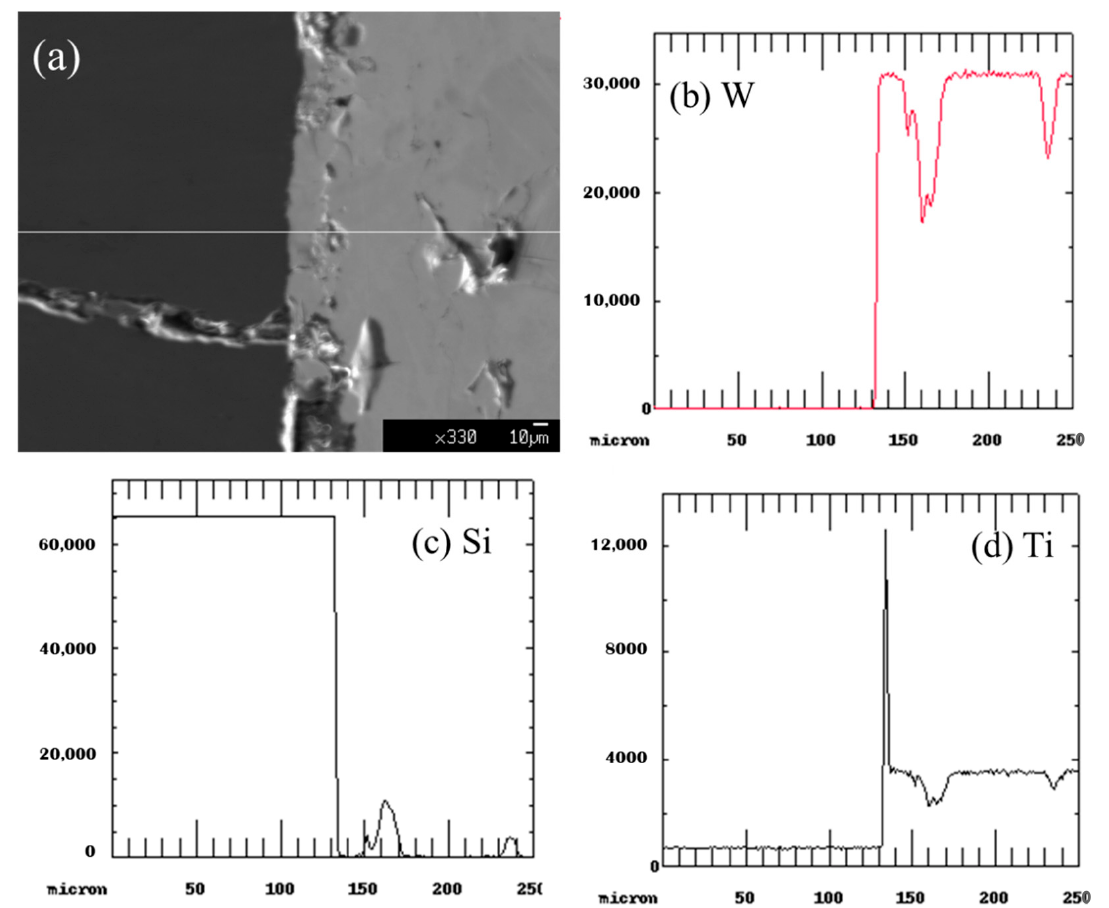
Figure 13. SEM images and EPMA results of cross-section of sputtered coated SiC joined with Wfoils. ( a ) cross-sectional SEM images of TiN-coated SiC and W; ( b ) cross-sectional SEM images of ZrN-coated SiC and W.